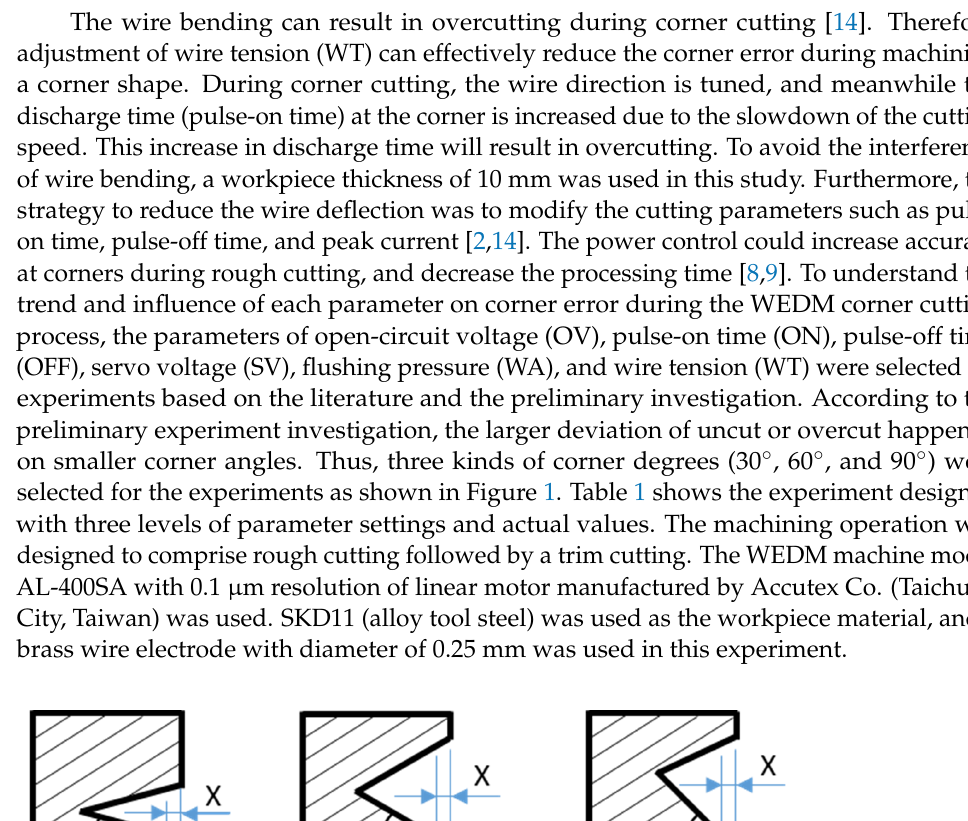
Figure 2. Flowchart of experiment. 2.2. Response Surface Methodology Response surface methodology (RSM) is an advanced experimental design method that combines mathematics and statistics that are helpful for analyzing the problem and